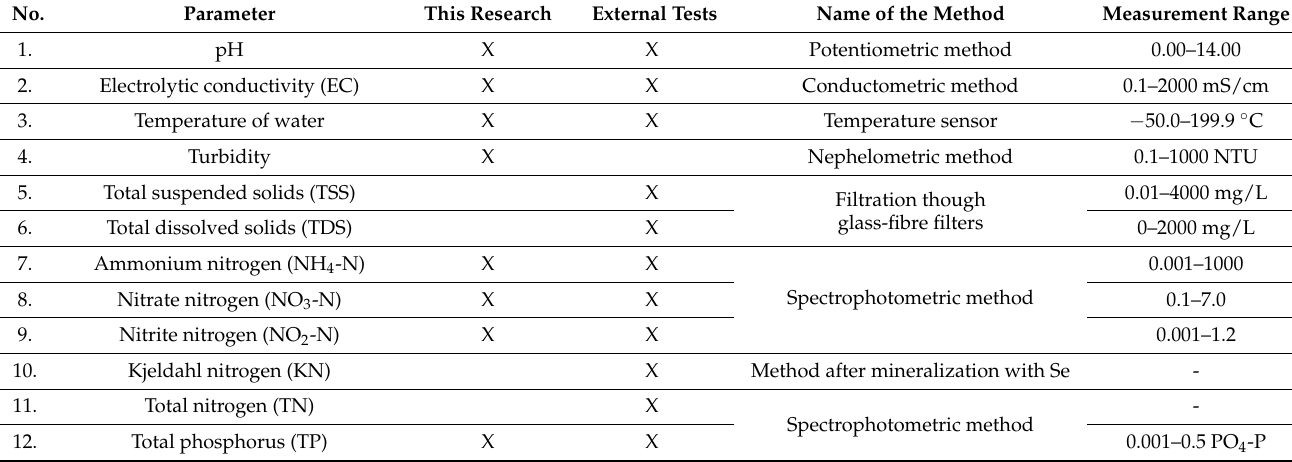
Table 3. List of tested physicochemical parameters with methods of their